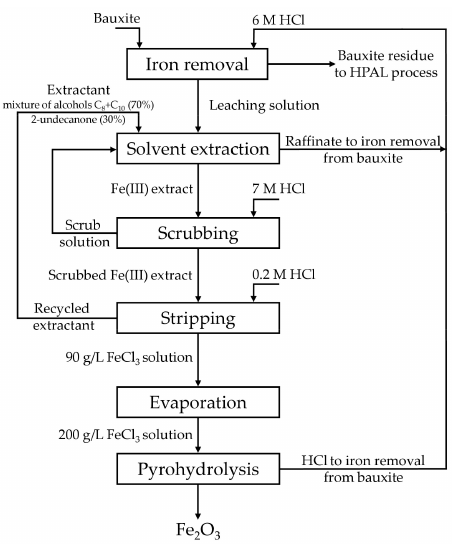
Figure 14. Schematic flowsheet of iron(III) removal from the chloride solution after bauxite HCl